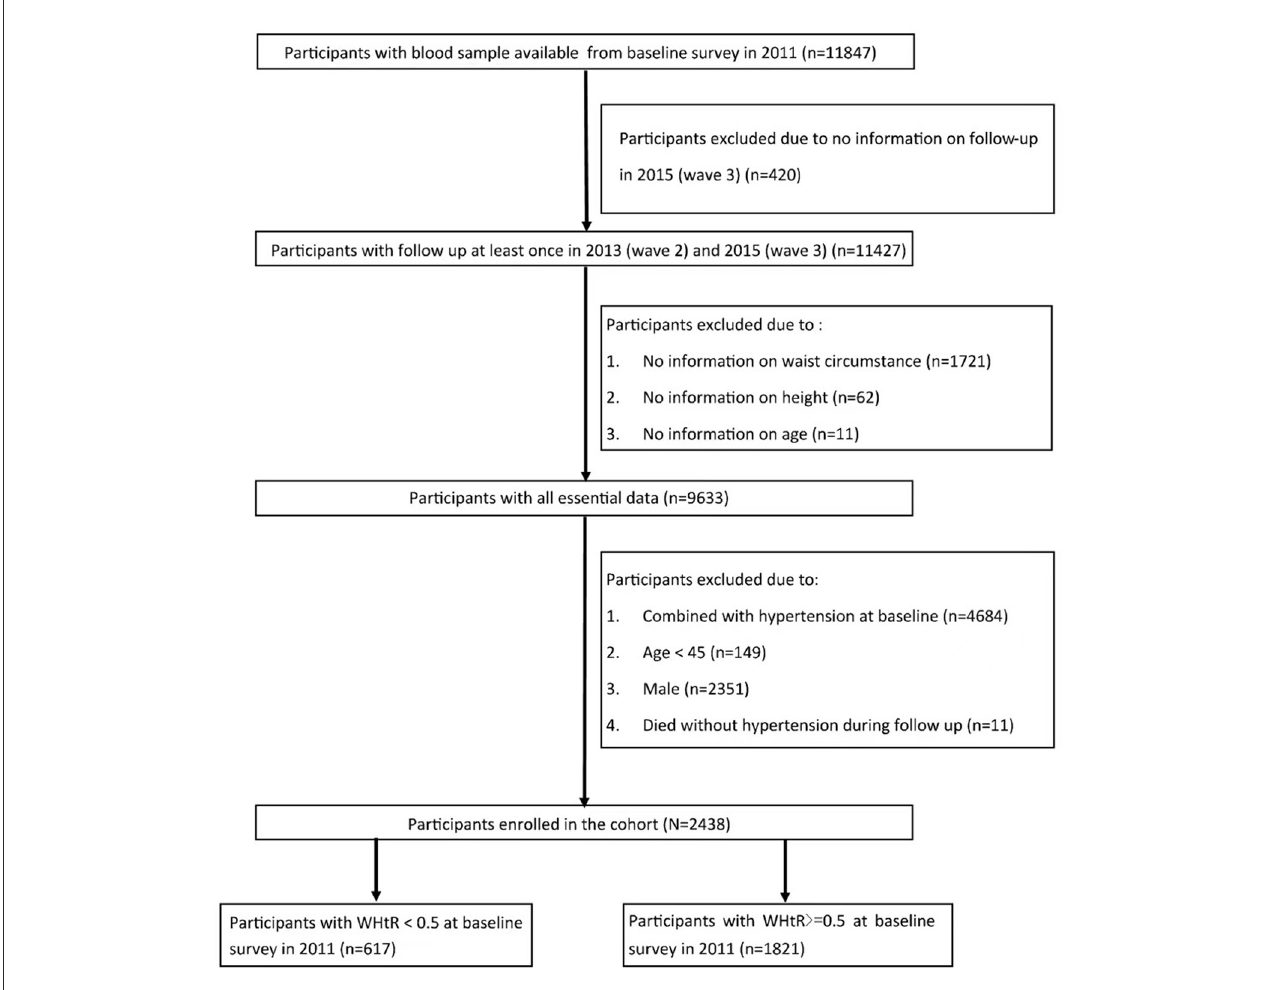
FIGURE1 Flow chart of the